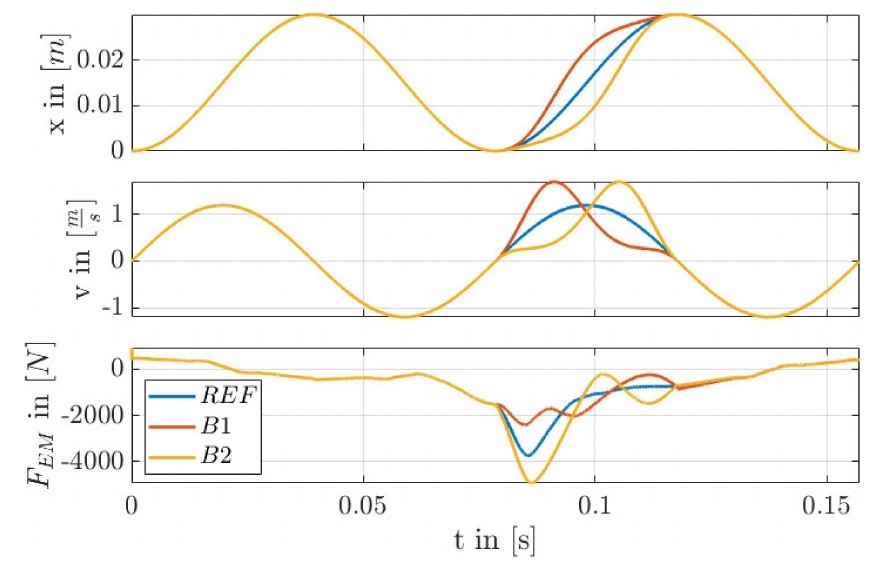
Figure 22. Comparison of trajectories REF, B1 and B2 related to the energy conversion of the electrical machine: illustration of the stroke, velocity and electric machine force depending on